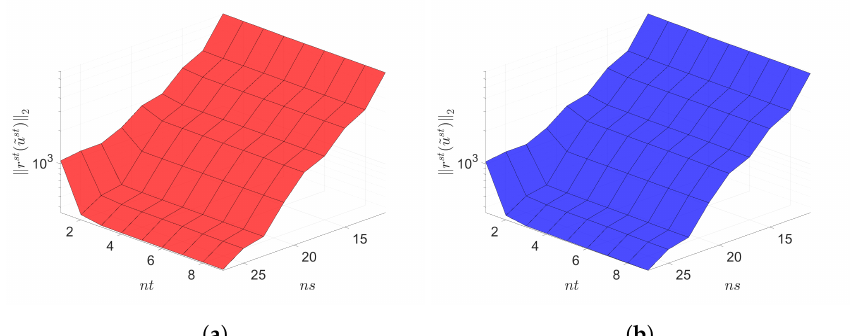
Figure 18. 2D linear convection diffusion equation with source term. Relative errors vs. reduced dimensions. Note that the scales of the z -axis, i.e., the average relative error, are the same both for Galerkin and LSPG. Although the Galerkin achieves slightly lower minimum average relative error values than the LSPG, both Galerkin and LSPG show comparable results. ( a ): Relative errors vs. reduced dimensions for Galerkin projection, ( b ): Relative errors vs. reduced dimensions for LSPG projection.